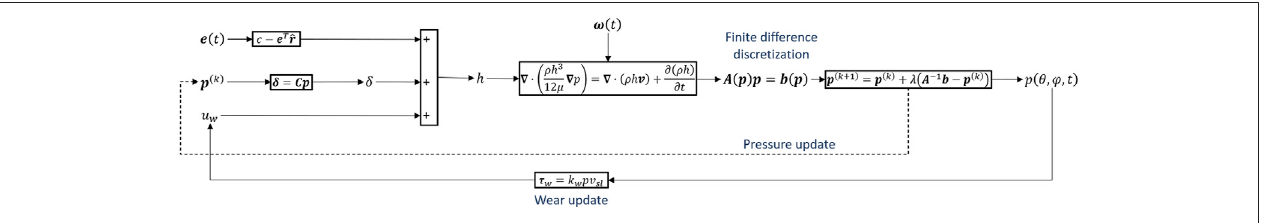
FIGURE 3 | Elasto-hydrodynamic lubrication model fl